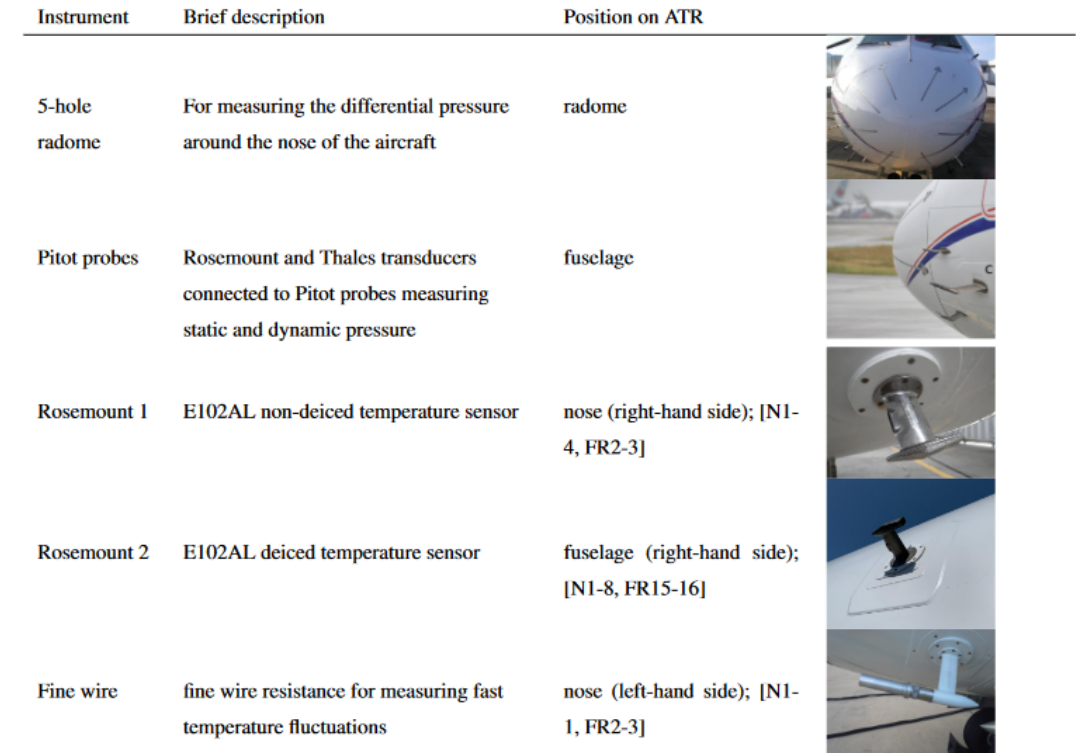
Table 5. Core instrumentation of the ATR for pressure and temperature measurements. See Appendix D for the correspondence between the position H, N or FR and the ATR configuration (H refers to an aircraft window, N to the nose of the aircraft and FR to a particular position along the